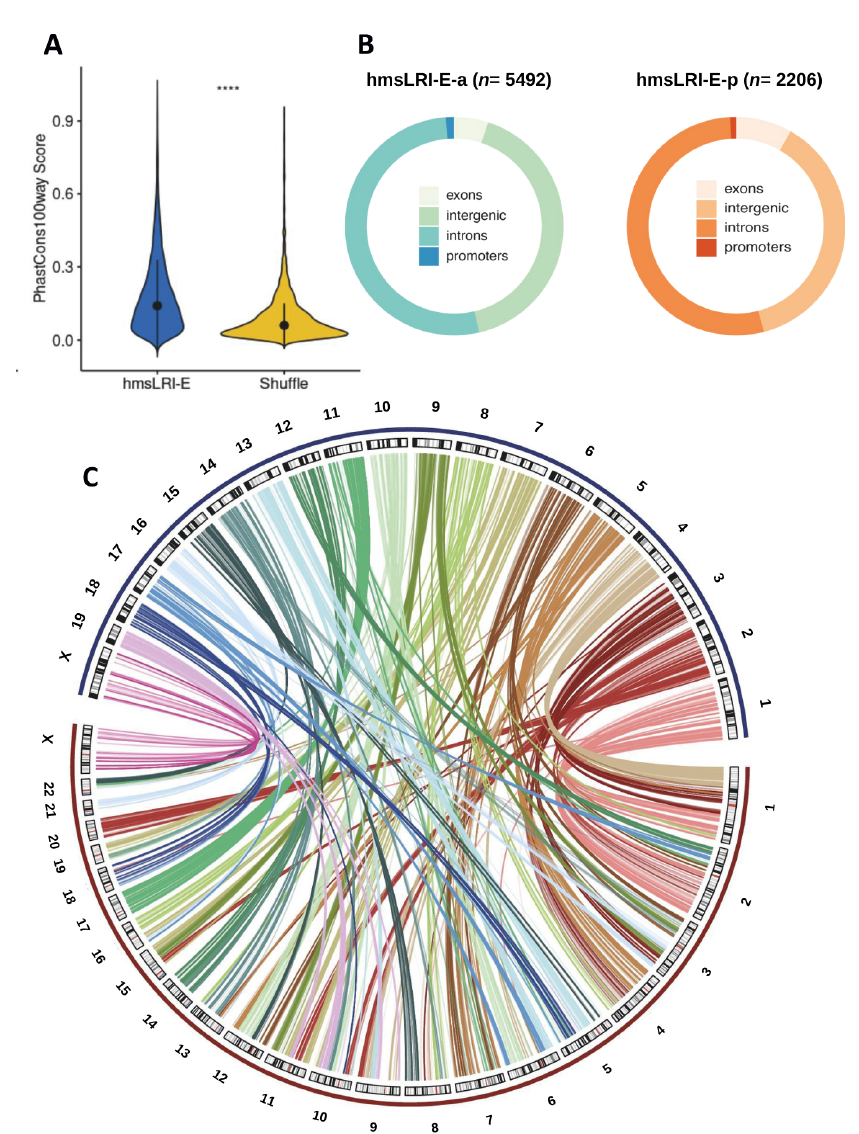
Figure 2. Conservation and synteny between mouse and human LRI-E and LRI . ( A )—Violin plots showing sequence conservation of hmsLRI-E, versus random shuffled genomic regions with similar GC content (**** p < 0.0001, Wilcoxon rank-sum test). PhastCons score over 100 vertebrates is reported. Lines span the first to third quartiles (Q1 to Q3), dots denote the median. ( B ) Ring chart with the fraction of hmsLRI-E (active on left and poised on right) overlapping exonic, intergenic, intronic or promoter regions in the human genome. ( C )—Circos plot showing the genomic correspondences of enhancers involved in LRI between mouse and human. Mouse chromosomes are represented in blue (chr1-19, X), human chromosomes are in red (chr1-22,